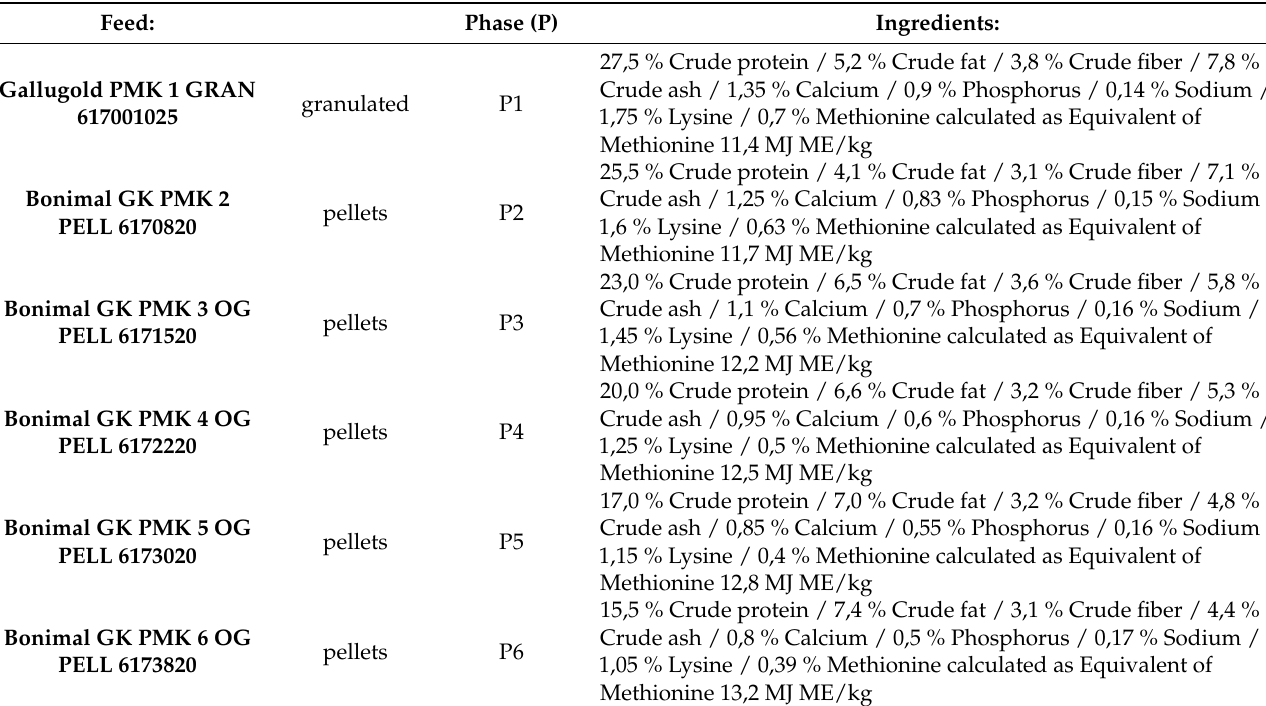
Table A1. Ingredients of turkey feed. Feed manufracturers: Deutsche Tierernährung Cremer GmbH & Co. Kg, Passauerstraße